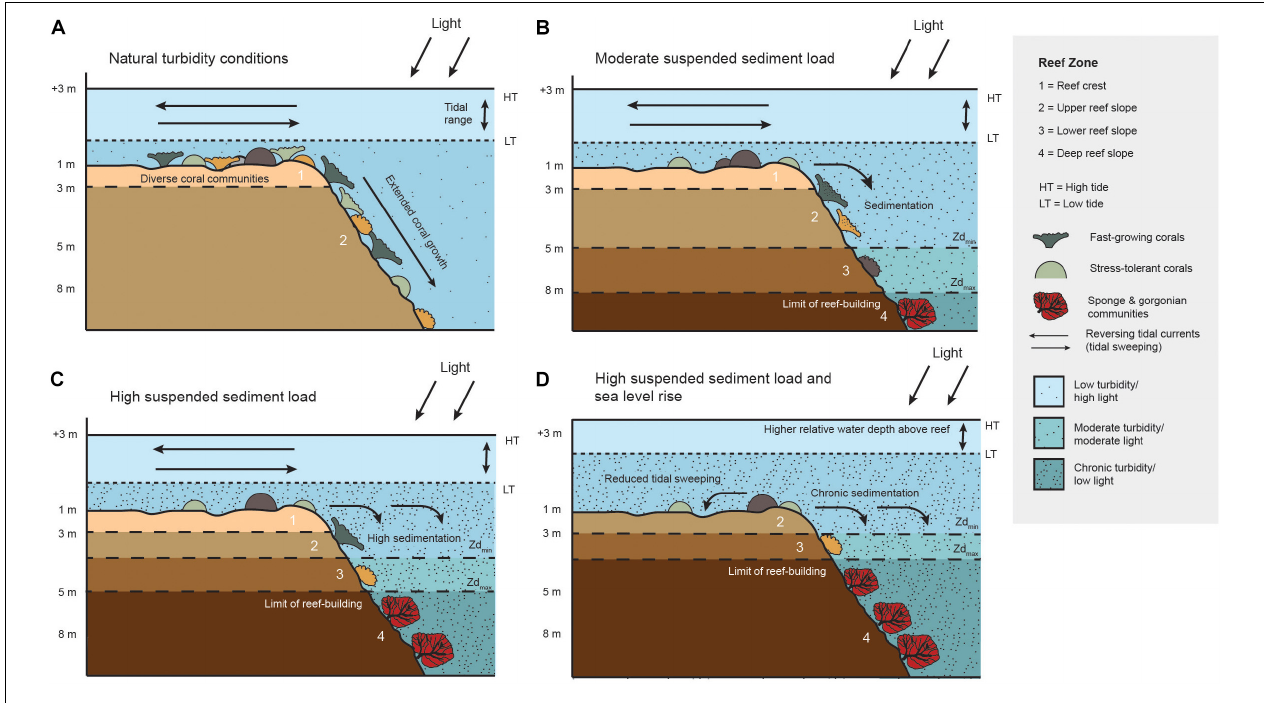
FIGURE 8 | Schematic diagram demonstrating vertical reef compression on turbid coral reefs caused by a shoaling euphotic depth (Zd) and higher net sedimentation on the reef slope. Panels show how the photic zone and benthic communities respond to local and climate-related impacts: (A) natural turbidity conditions, (B) moderate suspended sediment load, (C) high suspended sediment load, and (D) combined high suspended sediment load and sea level